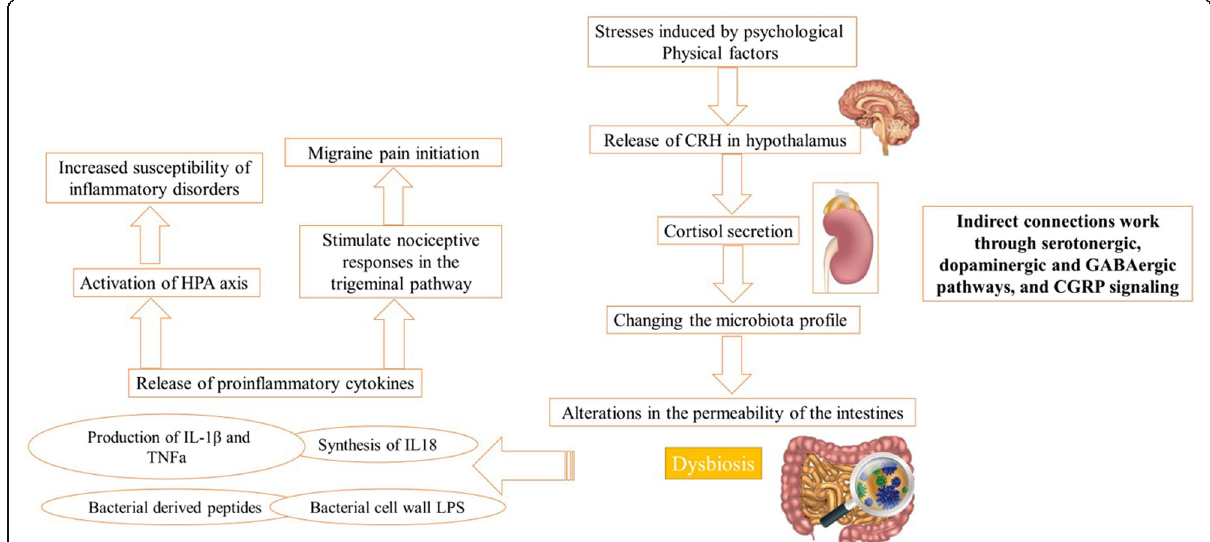
Fig. 2 Mechanisms of the effects of gut bacteria in keeping normal balance of gut-brain axis via indirect signaling. CGRP, Calcitonin gene-related peptide; CRH, Corticotrophin-releasing hormone; HPA, Hypothalamic pituitary adrenal axis; LPS, lipopolysaccharides; IL, Interleukin; TNFa, Tumor necrosis factor